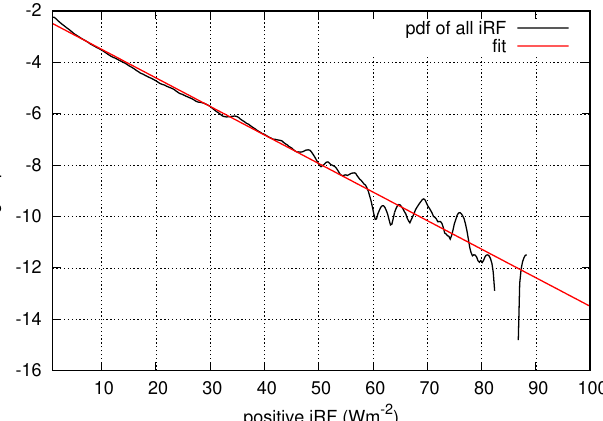
Figure 3. Probability density functions of the distribution functions shown in Figure 1 (right). Left panel : linear axes, right panel : logarithmic y-axis.